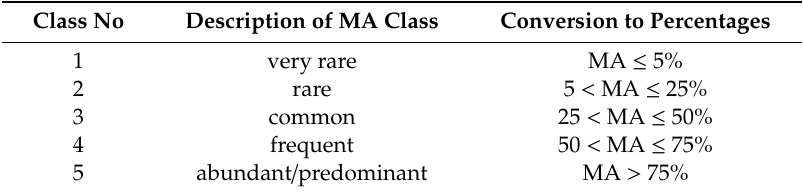
Characteristics of the macrophyte abundance (MA) classes and their conversion to percentages